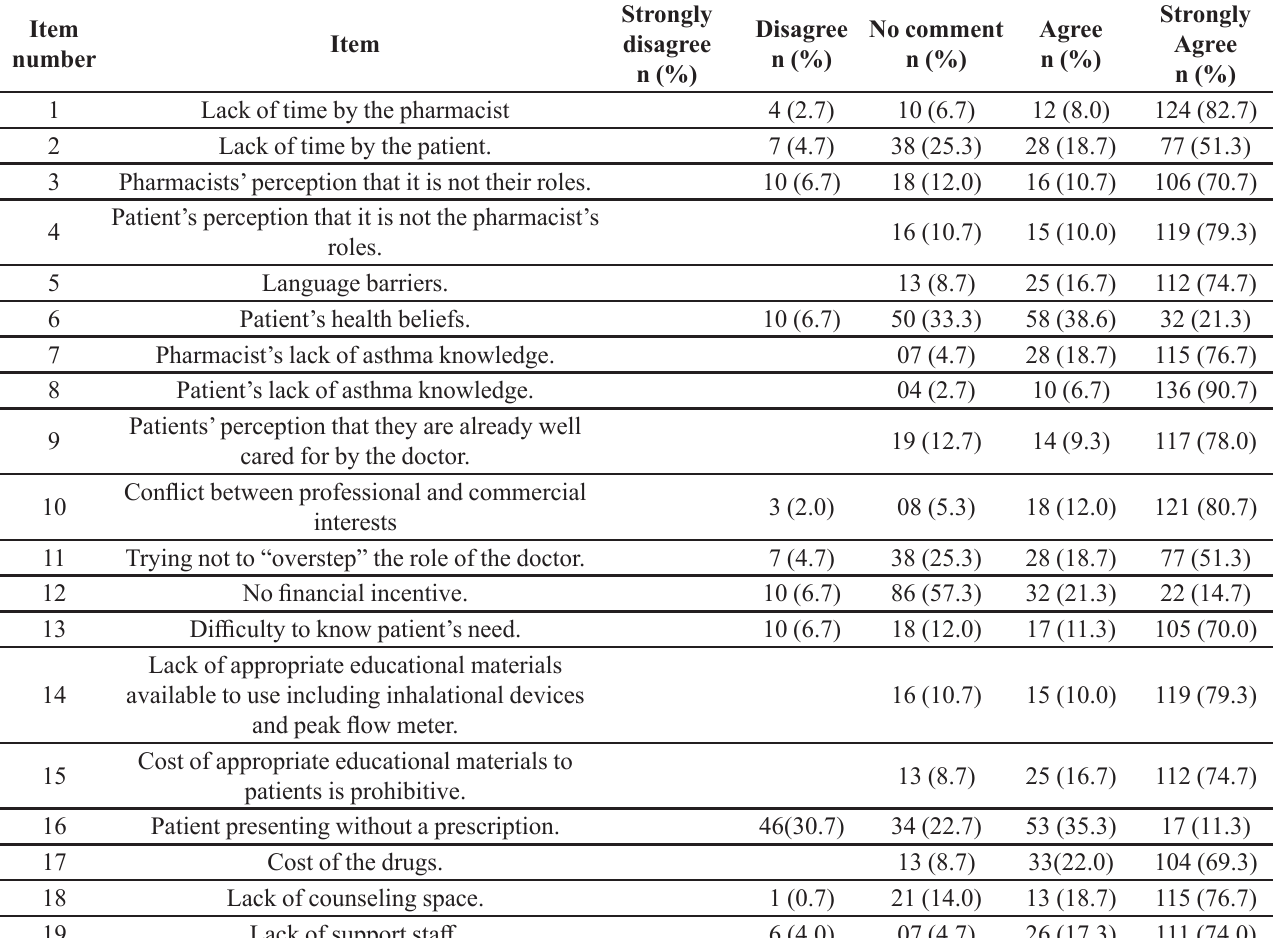
TABLE IV - Response of pharmacists towards barriers in asthma management Indicate to what extent you feel each of the following factor impact on the pharmacist’s ability to provide specific asthma counseling or services Item number